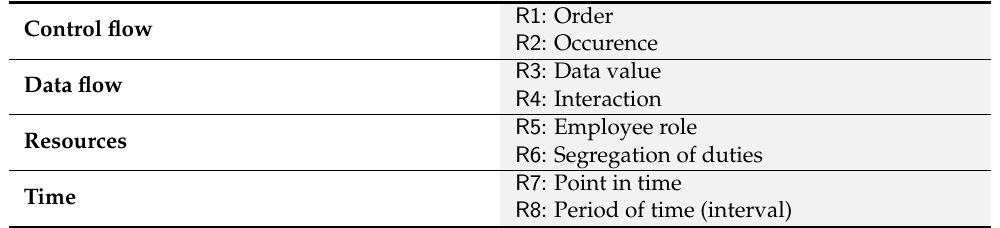
Table 2. Classification of compliance requirements based on process aspects. Control